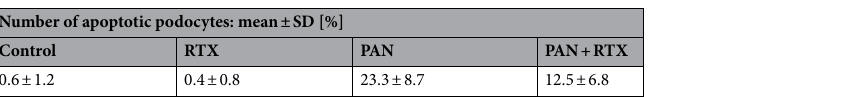
Table 2. Rituximab prevents nuclear fragmentation in human podocytes. Hoechst nuclear staining was performed for the detection of apoptosis. Apoptotic cells were defined as percentage of condensed/fragmented nuclei. RTX = rituximab (100 µg/ml); PAN = puromycin aminonucleoside (30 µg/ml). Treatment time: 48 h; n = 4 experiments; ≥ 200 cells per condition. Data are means (%) ± SD.